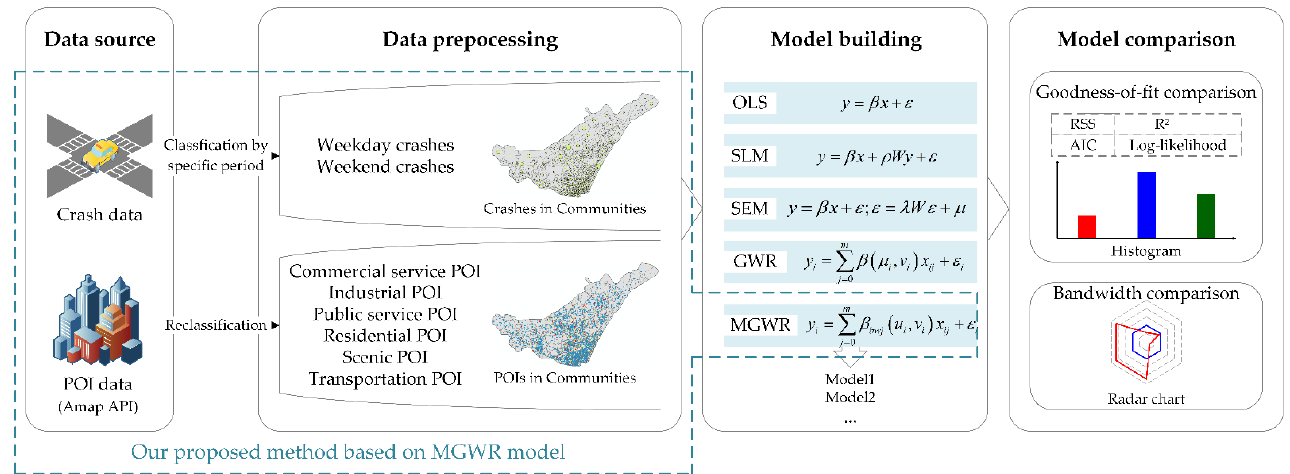
Figure 2. Flowchart of our study.